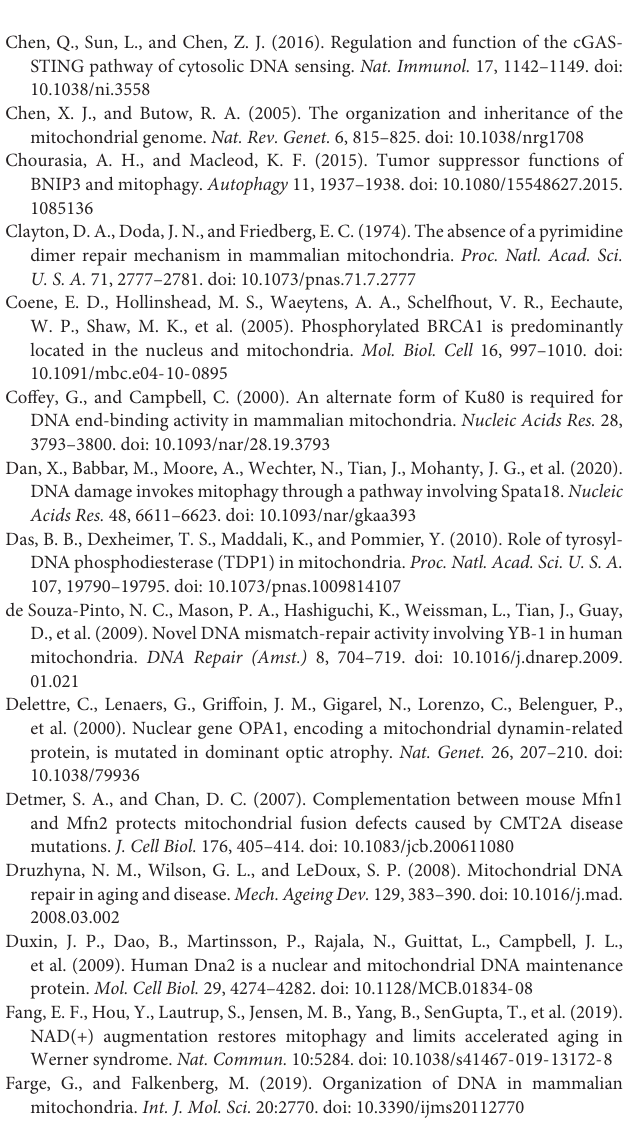
Supplementary Table 1 | Enzymes/proteins in mtDNA repair. Important enzymes/proteins in mammalian mitochondria in different mtDNA damage repair mechanisms are present. Functions of each enzyme/protein are also